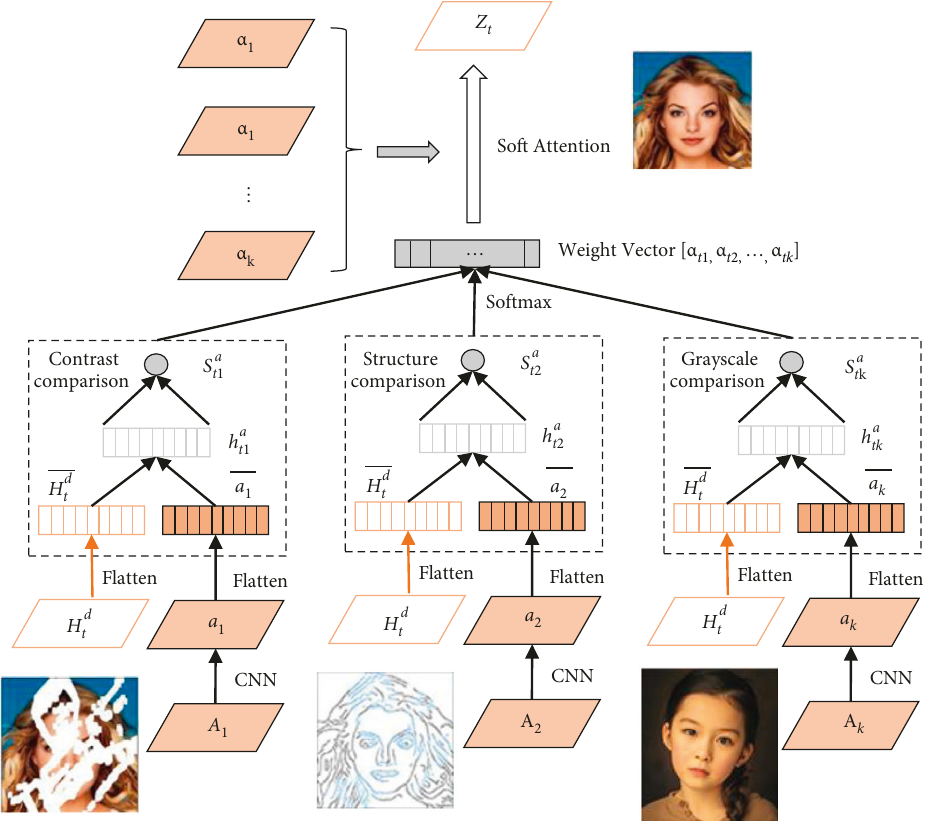
Figure 1: Schematic diagram of a numerical media art evaluation algorithm based on locally weighted fitting. Reference images